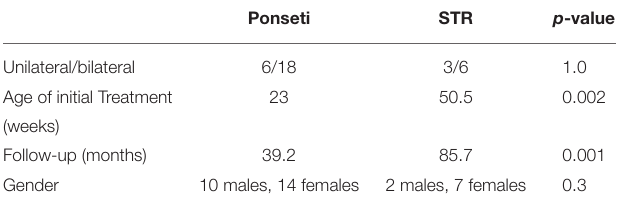
TABLE 2 | Patient demographics.